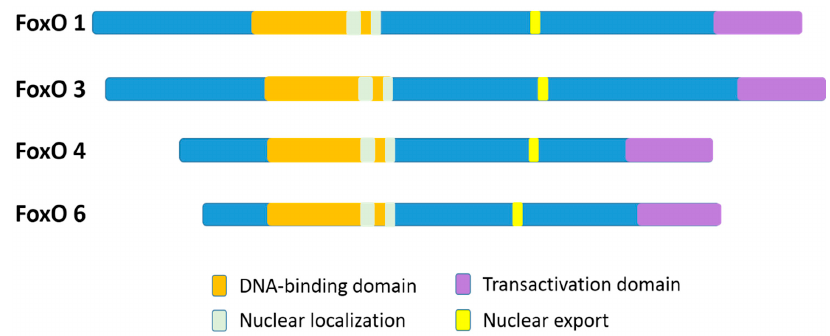
Figure 1. A schematic diagram of the four different functional motifs of the mammalian FoxO family members (FoxOs). For humans, FoxO1, FoxO3, FoxO4, and FoxO6 proteins are 655 aa, 673 aa, 505 aa, and 492 aa in size, respectively. The functional domains are the forkhead domain, nuclear